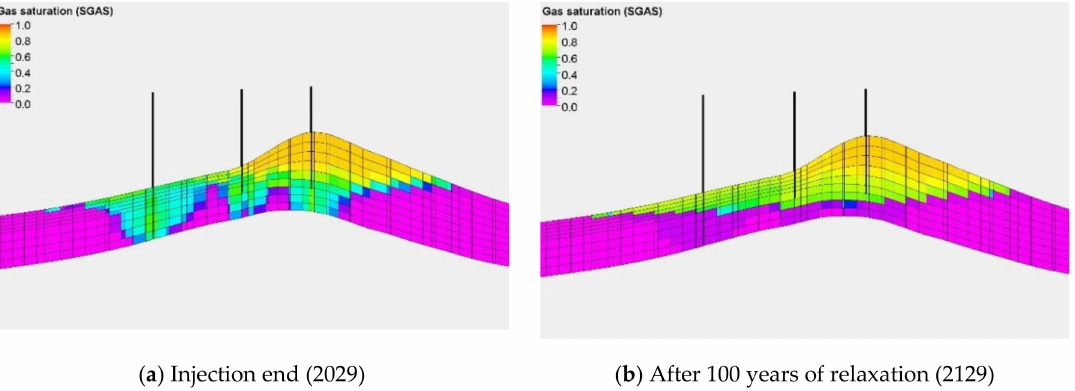
Figure 44. Distribution of gas saturation along the vertical cross section (A–A’).